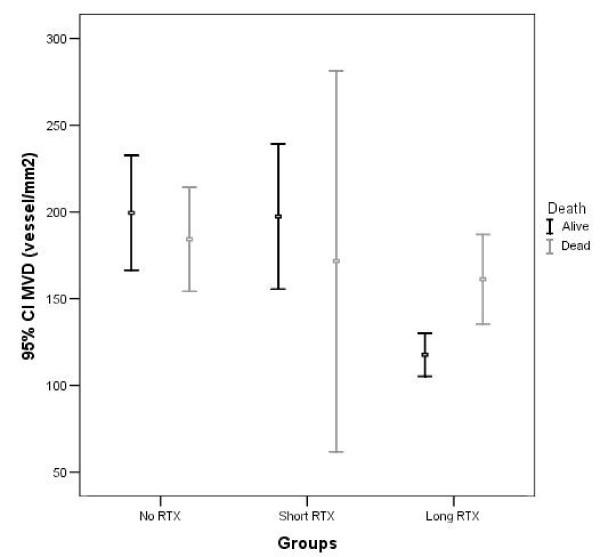
Distribution between mean ± SE of MVD (microvessel/mm2) and survival in untreated (no RTX), short term (short RTX) and long term RTX (long RTX) groups.